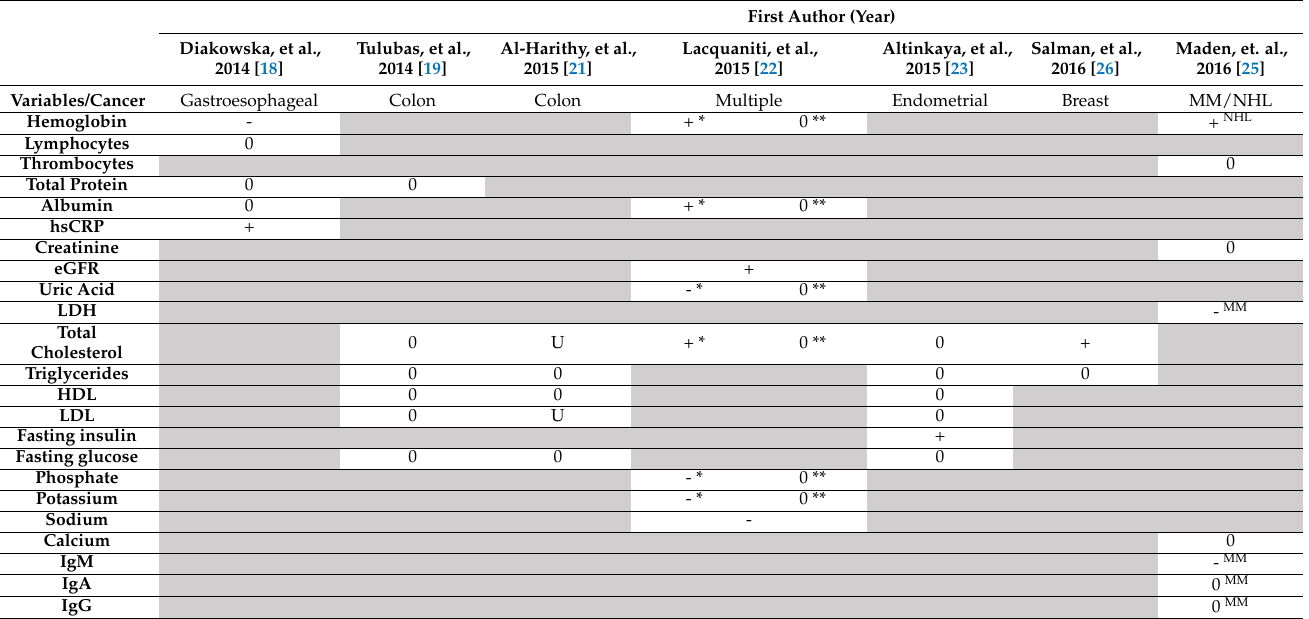
Table 4. Relationships Between Blood-Based Measures and Serum